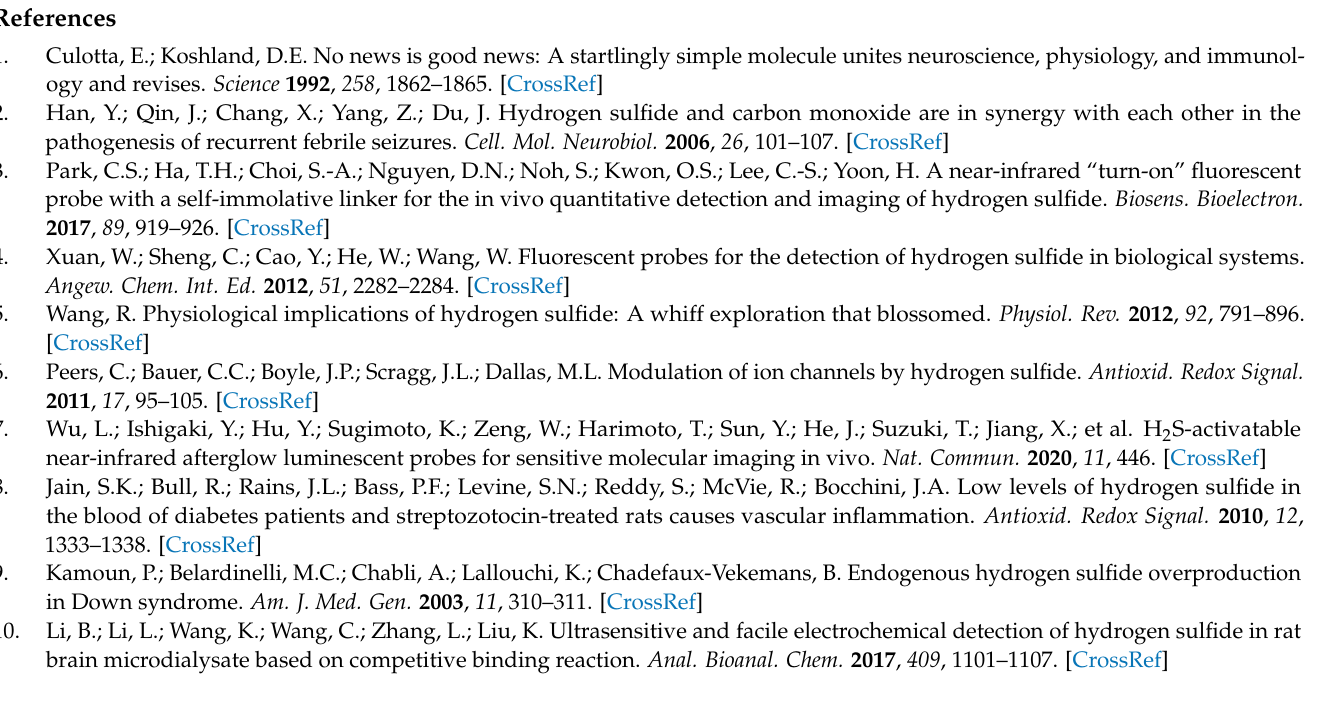
Figure S2: The fluorescence intensity at 568 nm and 516 nm of probe BH (5 µ M) toward increasing H 2 S concentration (0 − 500 µ M) in aqueous solution of DMSO/PBS ( v / v 1/1, pH 7.4); Figure S3: